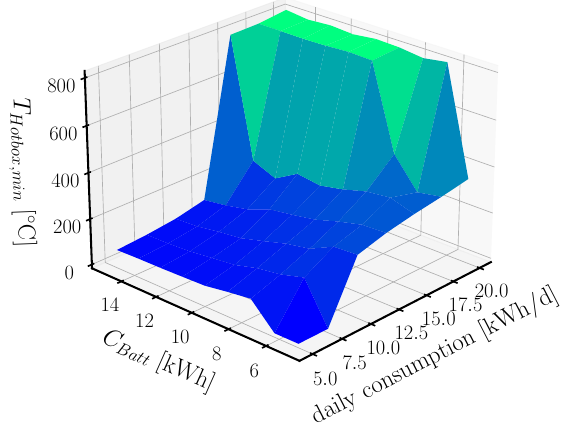
Figure 22. Minimum hotbox temperature during the thermal cycles of the SOFC system in shutdown mode for different daily electricity consumptions and battery